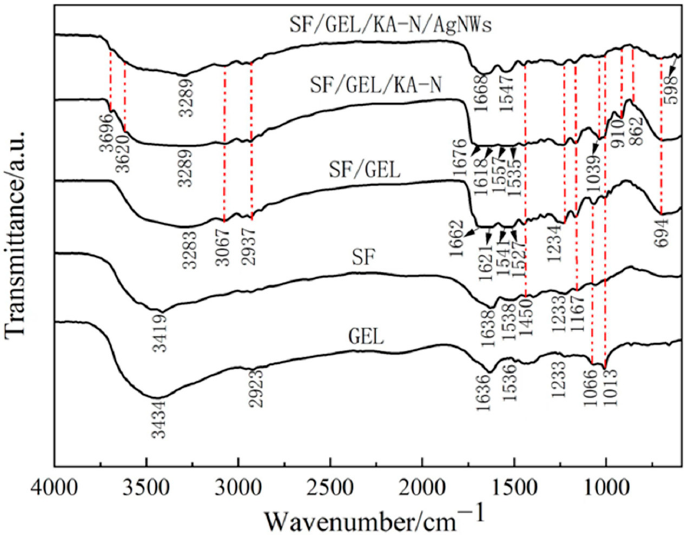
Figure 1. FTIR spectra of gelatin (GEL), silk fibroin (SF), silk fibroin/gelatin (SF/GEL), silk fibroin/gelatin/kaolinite nanotubes (SF/GEL/KA-N), and silk fibroin/gelatin/kaolinite nanotubes/silver nanowires (SF/GEL/KA-N/AgNWs).